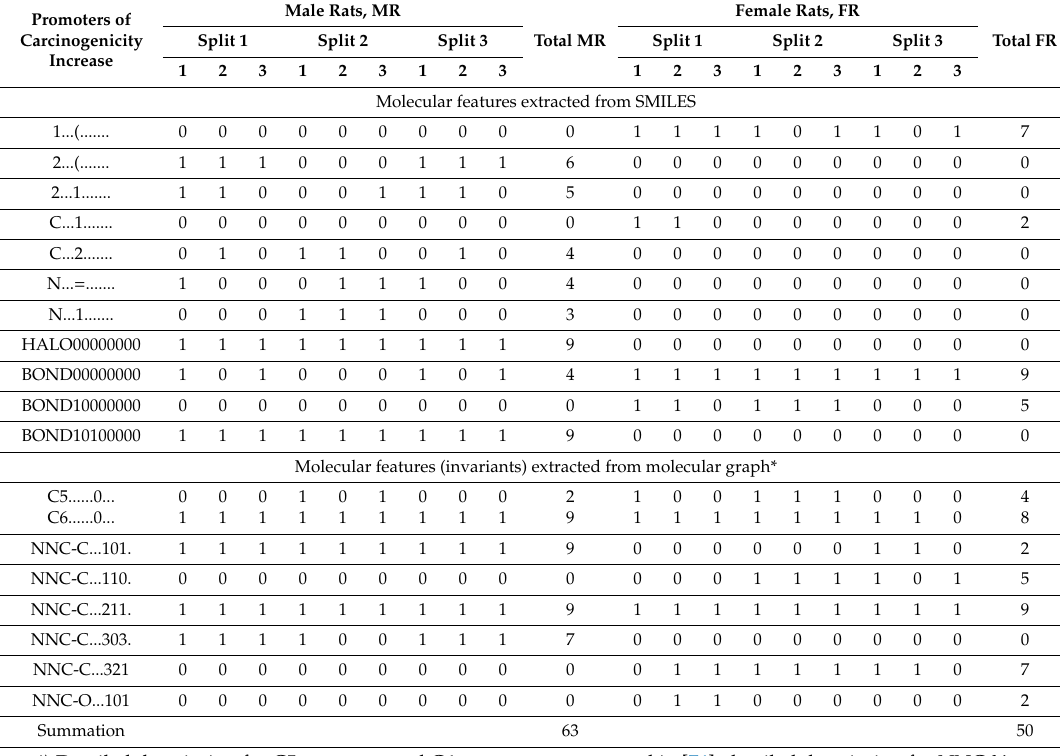
Table 8. Promoters for increase carcinogenicity in male rats (MR) and female rats (FR). Promoters of Carcinogenicity Increase Molecular features extracted from